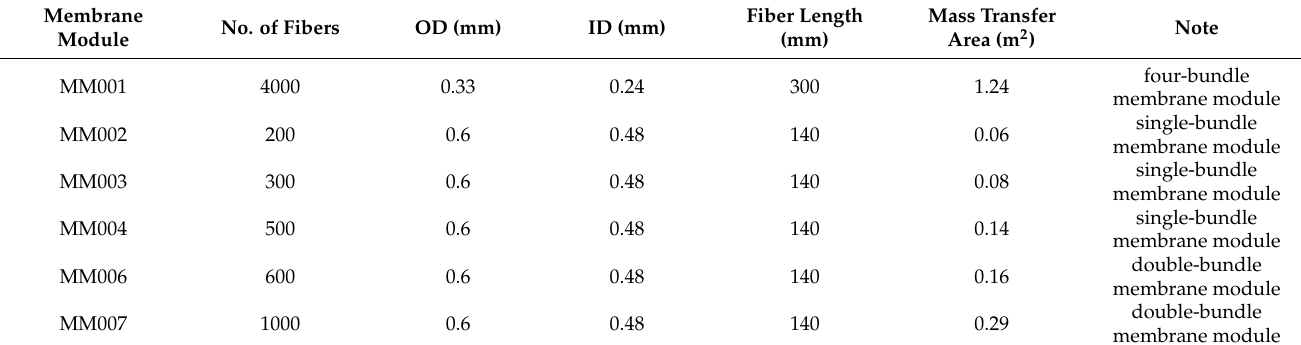
Figure 2. A condenser made of non-porous polypropylene hollow fibers. The optimization of the membrane module required six different configurations. They differ in the number of fibers, the OD of the fibers, and the length of the fibers. All bundles were potted in a DN 16 PVC tube. The properties of the membrane modules are listed in Table 1. Examples of a single-bundle and double-bundle membrane module are shown in Figure 3. Table 1. Properties of membrane modules.